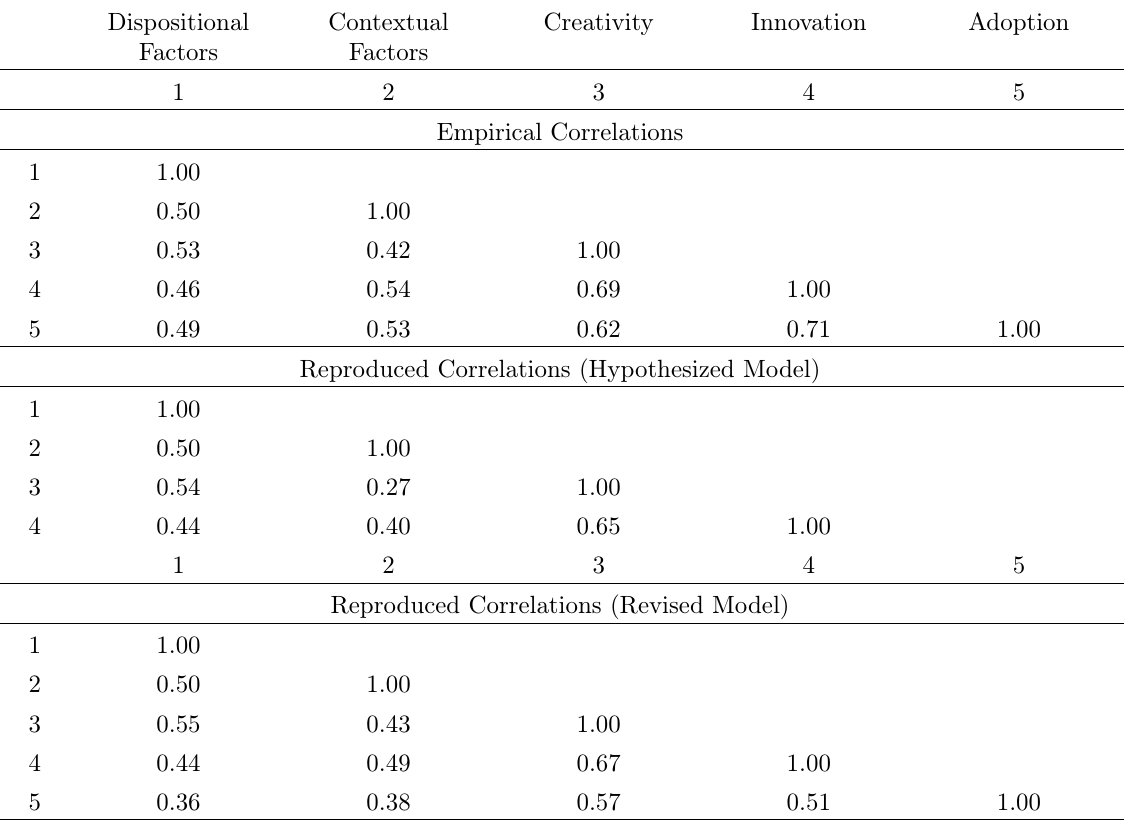
Summary of the Empirical and Reproduced Correlations for the Endogenous and Exogenous Factors in the Hypothesized and the Revised